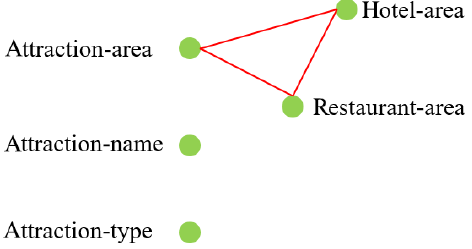
Fig. 2 Example of the graph describing associations between nodes. Nodes are in green and edges are in